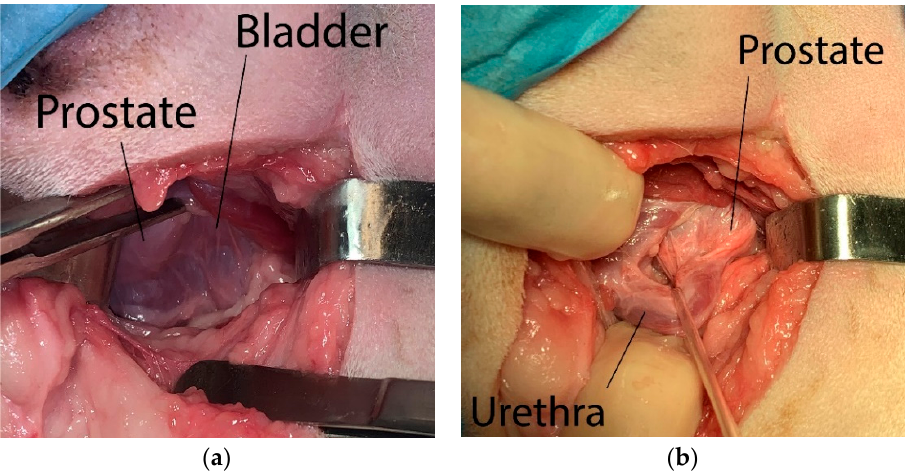
Figure 1. Surgery steps: ( a ) the prostate and the bladder are identified after perineal incision and blunt dissection; ( b ) a sterile disposable Penrose drain set or a silicone vascular tape was then positioned around the urethra to better identify it during the subsequent steps of the procedure.